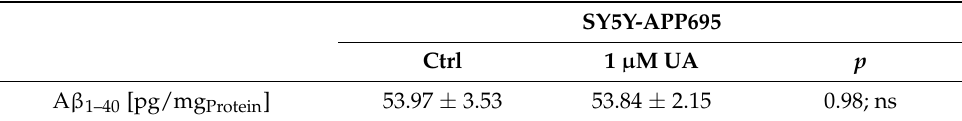
Table 1. A β 1–40 levels in SY5Y-APP695 cells treated with 1 µ M UA or control (ctrl). A β was determined via Homogeneous Time Resolved Fluorescence (HTRF). Data is adjusted to protein content of the samples. Data is displayed as mean ± SEM. N = 10. Statistical significance was tested via Student’s t -test. Statistical differences are given as ns p >